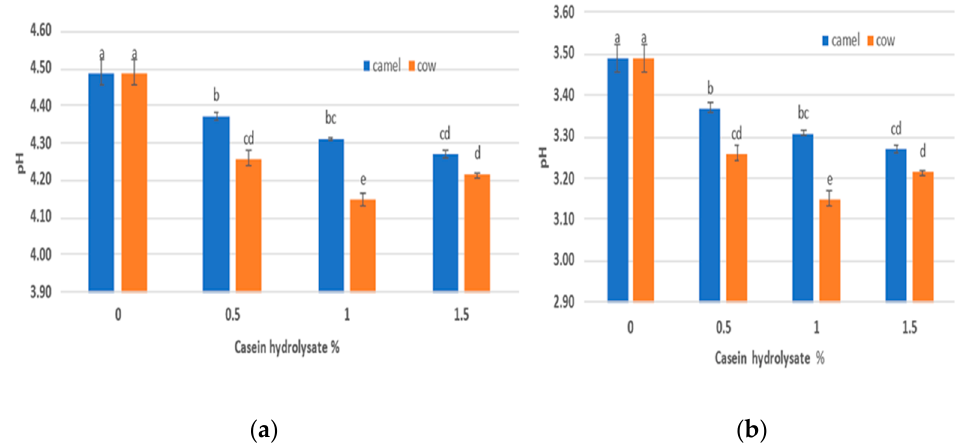
Figure 4. The change in pH during the fermentation of casein hydrolysate-treated yoghurt after one-day storage at 4 °C ( a ) and after storage for three weeks ( b ). No significant differences with the same letters among treatments